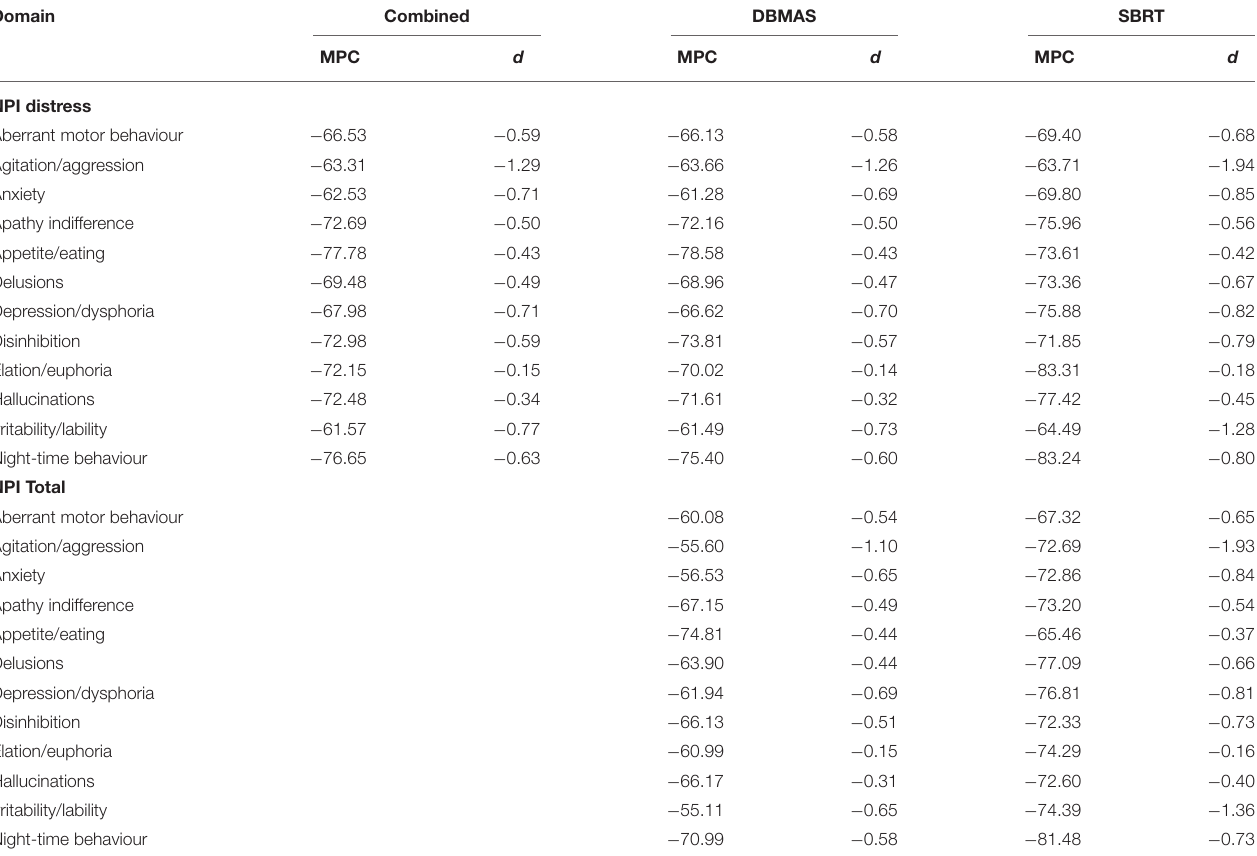
TABLE 5 | Clinical impact of DSA programs on NPI domain symptoms.